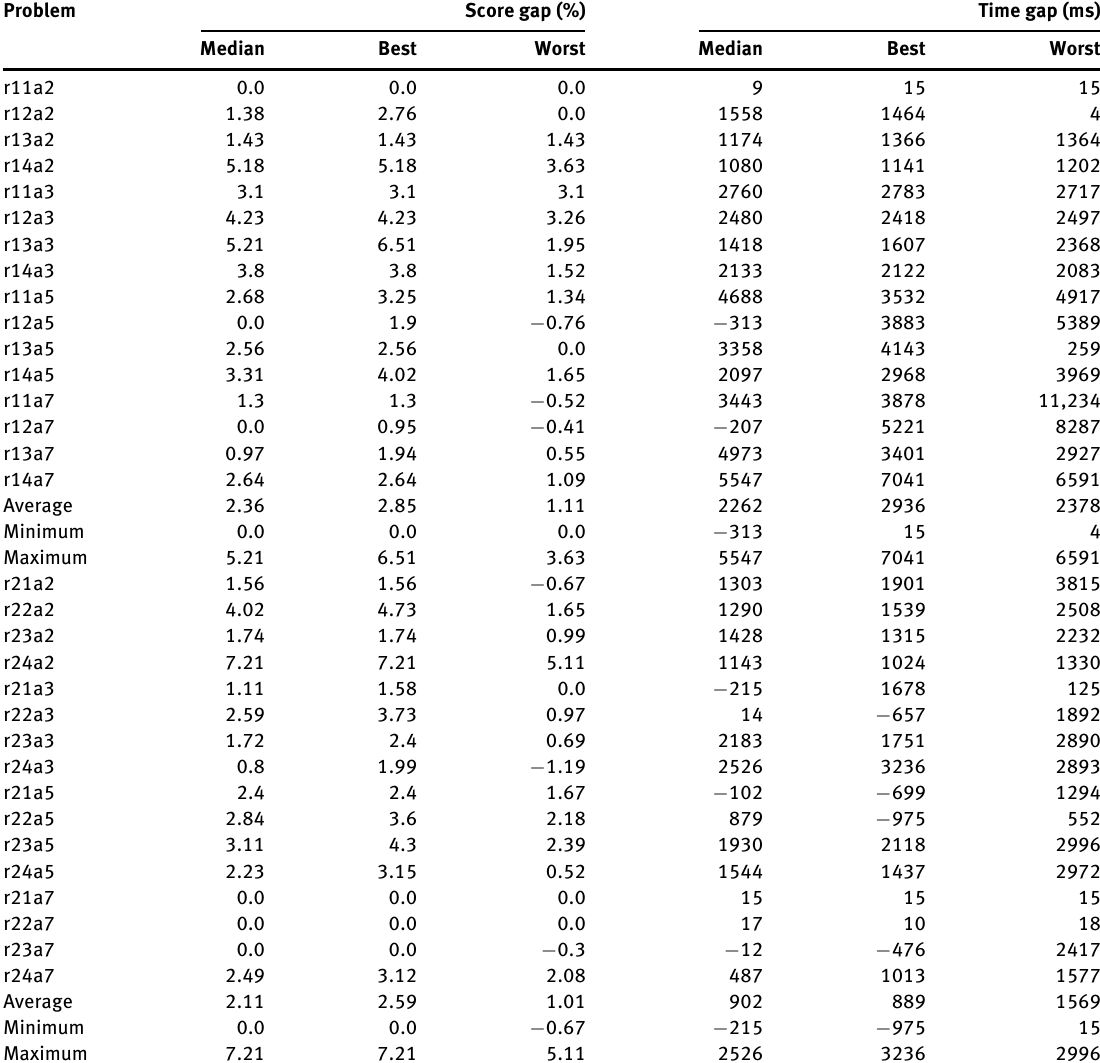
Table 1: Performance of Enhanced ILS vs . Baseline ILS, Average Per